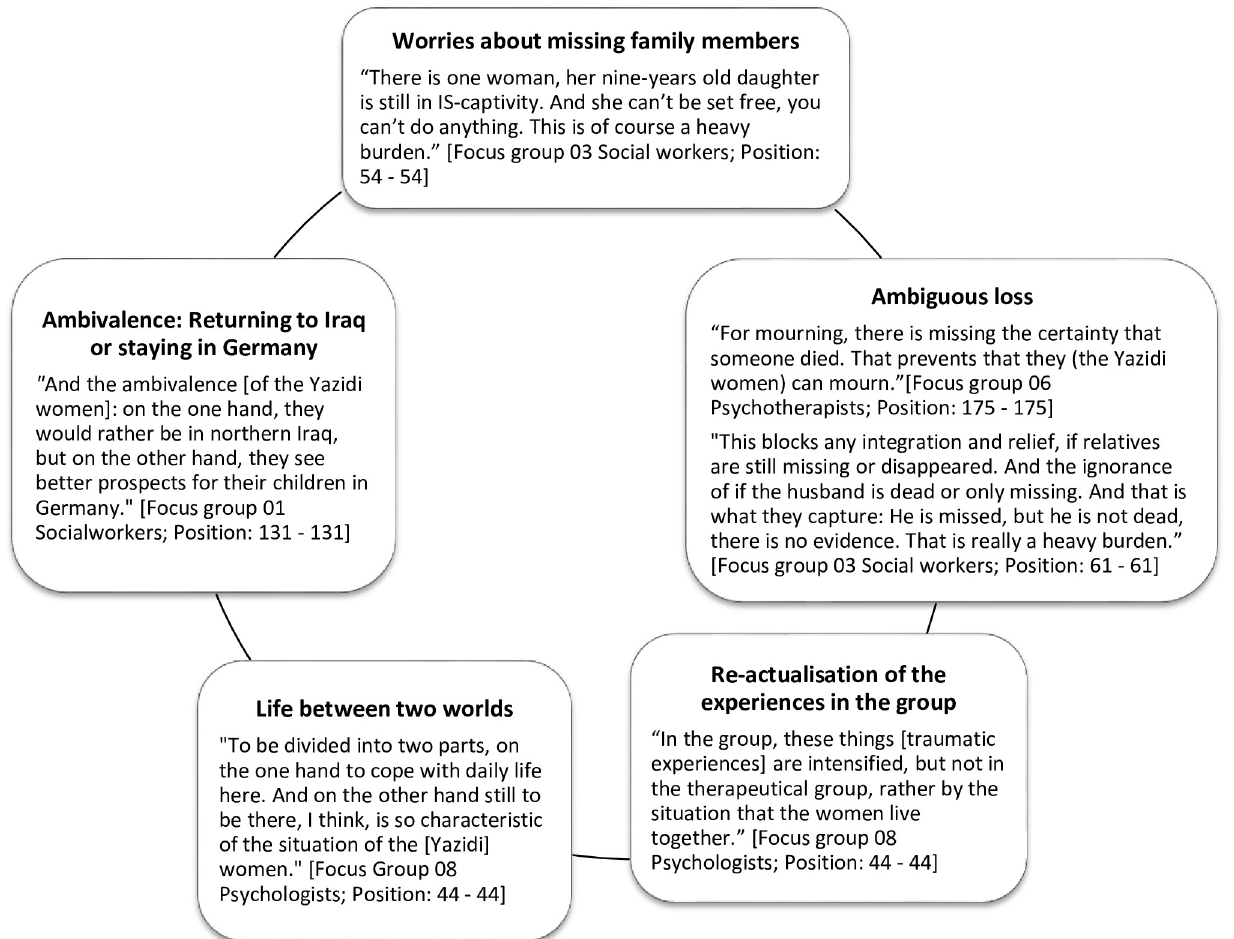
Fig 2. Main psychological burdens of female Yazidi refugees by the perspective of the care